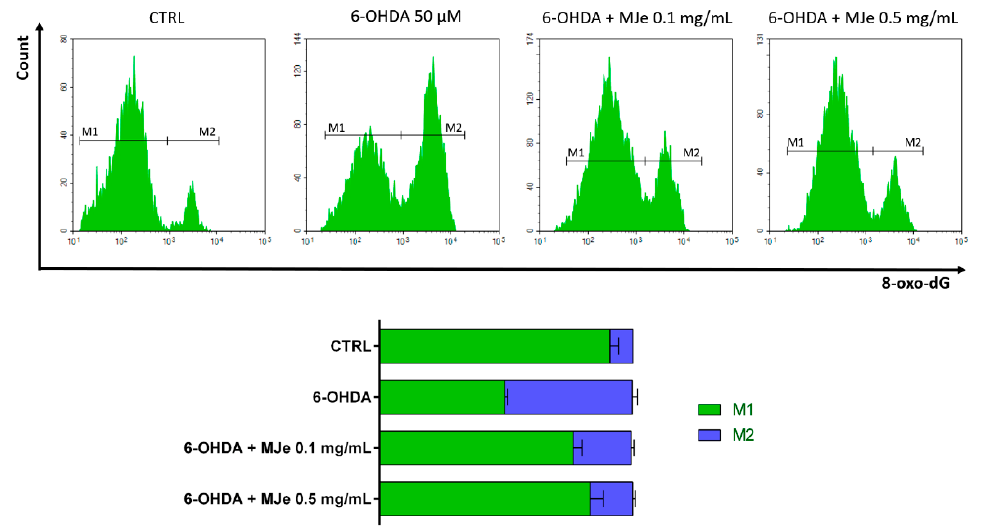
Figure 7. Protective effects of MJe on DNA oxidative damage induced by 6-OHDA. Levels of 8-oxo-dG are measured as emission signals of fluorochrome FITC-labelled avidin. The plots are representative of three independent experiments. The histograms show the percentage ± SEM of healthy cells (non-fluorescent, M1) and the damaged ones (fluorescent, M2) of three separate experiments in triplicate (N = 9).